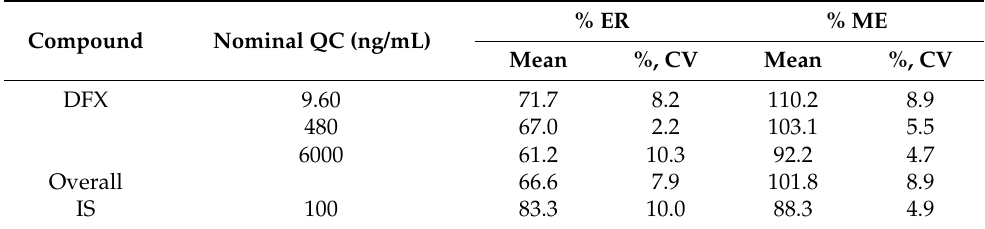
Table 3. The % extraction recovery and % matrix effects of DFX and IS in human plasma at LQC, MQC and HQC concentrations (n =